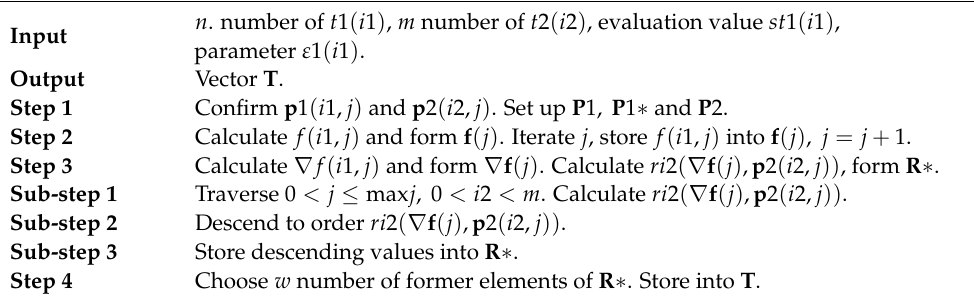
Algorithm 1 The water scenic spot recommendation algorithm based on the improved item-based collaborative